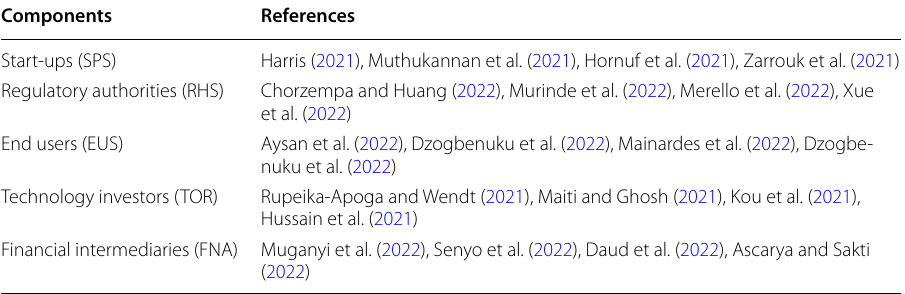
Table 9 Selected components for the fintech ecosystem Components